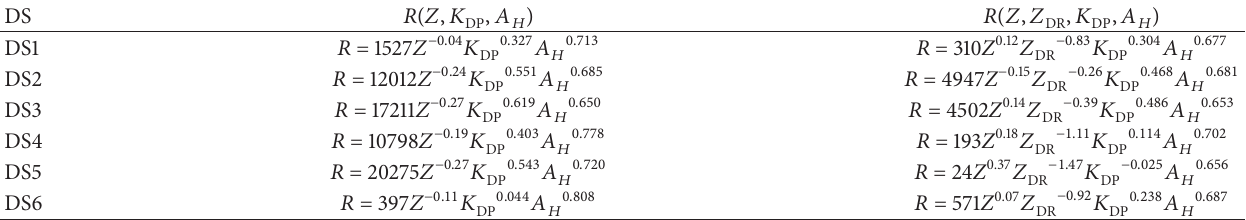
, 𝐴 ) and 𝑅(𝑍,𝑍 𝐻 DP